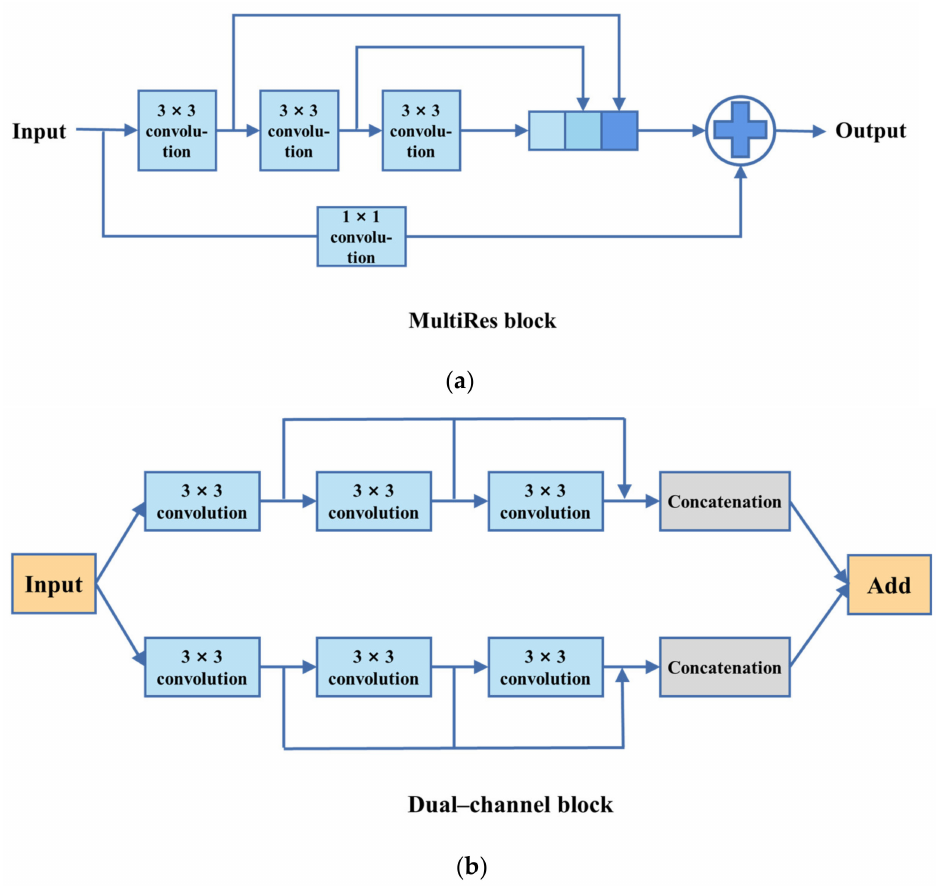
Figure 3. Structure to enhance the multiresolution analysis capabilities of the model. ( a ) MultiRes block, ( b ) dual-channel